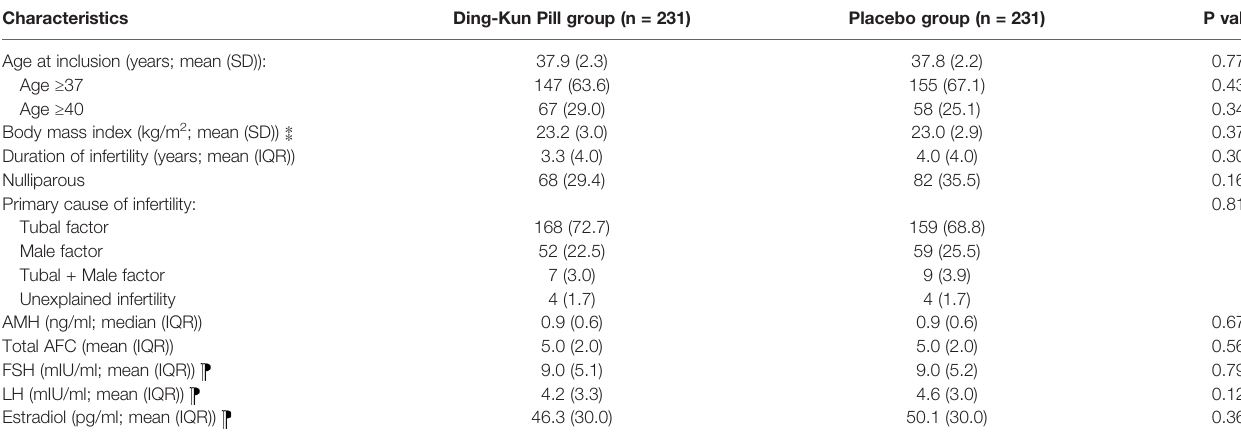
TABLE 1 | Participants ’ baseline characteristics on menstrual cycle days 2 – 3. Characteristics